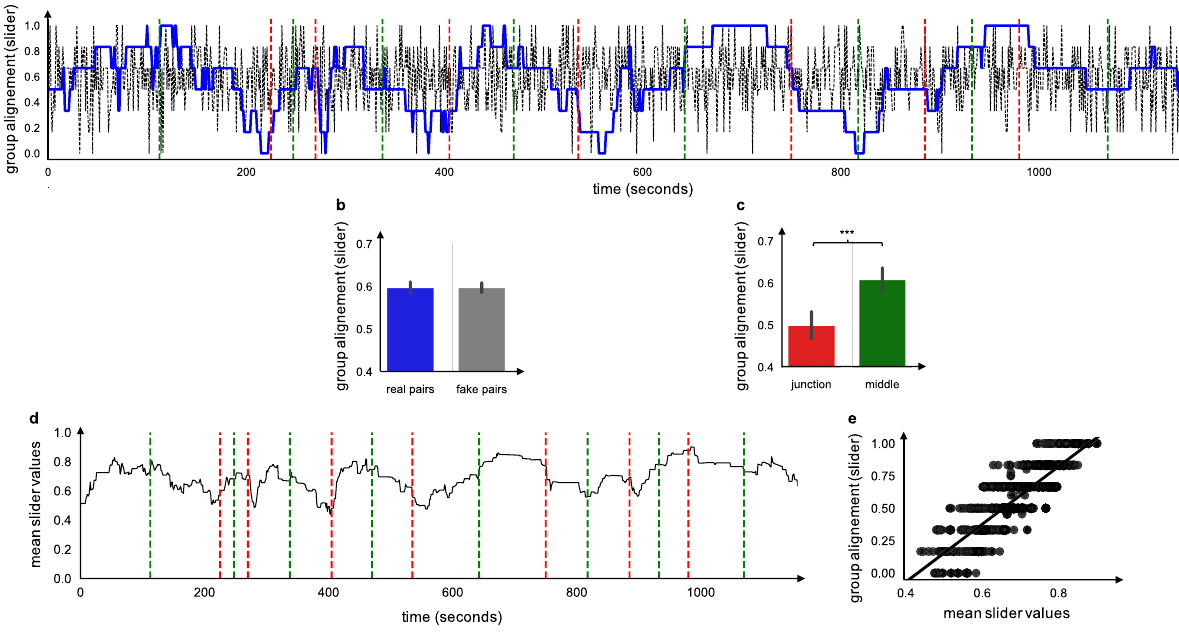
Figure 7. Directional intentions at the group level. ( A ) Group alignment was estimated for the directional intentions reported on the sliders at each second. Blue lines show the real values of group alignment, and grey dotted line group alignment computed over time scrambled data. Red dotted lines show the junctions between musical sequences, determined by the expert annotator. Green dotted lines show the middle of each musical sequence. ( B ) Comparison with chance. Group alignment for real pairs (blue) and time scrambled pairs (grey). ( C ) Evolution. Group alignment restricted to time windows centered around junctions (red) or the middle of the musical sequences (green) identified by the expert annotator. ( D ) “Group intention”, estimated at each second by averaging the values reported on the sliders across musicians. ( E ) Correlations between group average slider values vs. group alignment for slider values. We show the best fitting regression line, which was linear: this reflects the fact that agreement was typically related to an increased intention to support rather than to change the music. Each dot shows an individual time